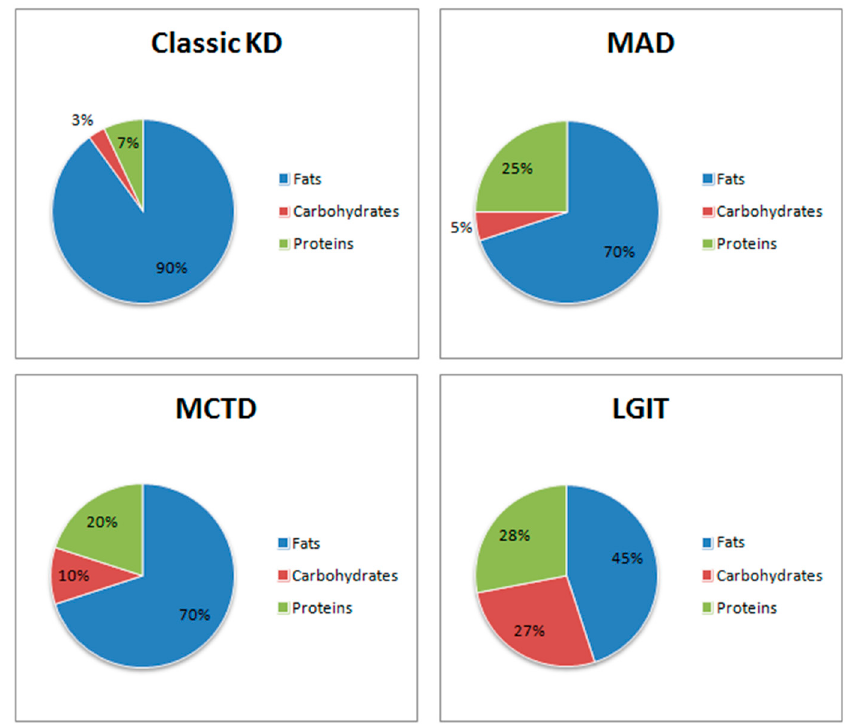
Figure 1. Comparison of selected modifications of the ketogenic diet and their macronutrient ratios. Classic KD- Classic Ketogenic Diet; MAD- High-Protein Ketogenic Diet; MCTD- Medium-Chain Triglycerides Diet; LGIT- Low Glycaemic Index Treatment.